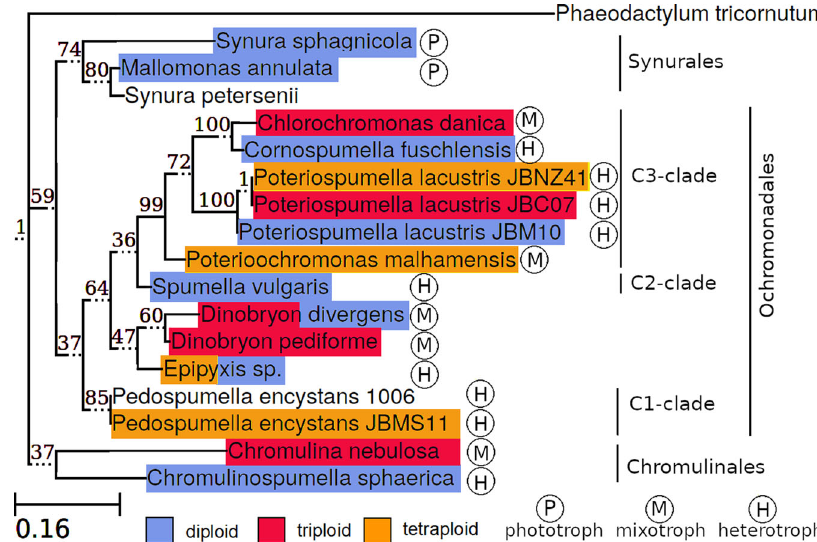
Fig. 3 Taxonomic distribution of ploidy. The ploidy (blue = diploid, red = triploid, and yellow = tetraploid) is independent of nutritional mode (phototroph, mixotroph, and heterotroph) or taxonomy. A phylogenetic tree is based on 18S rRNA gene